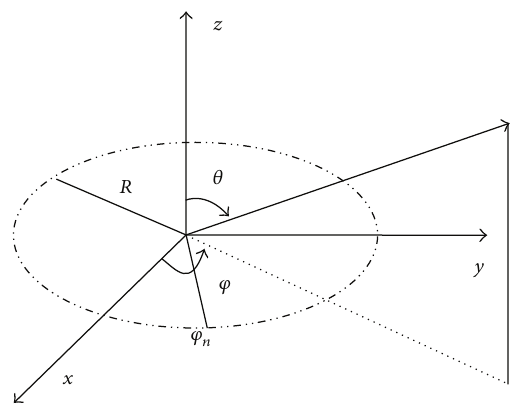
Figure 1: Far field coordinates for the circle array